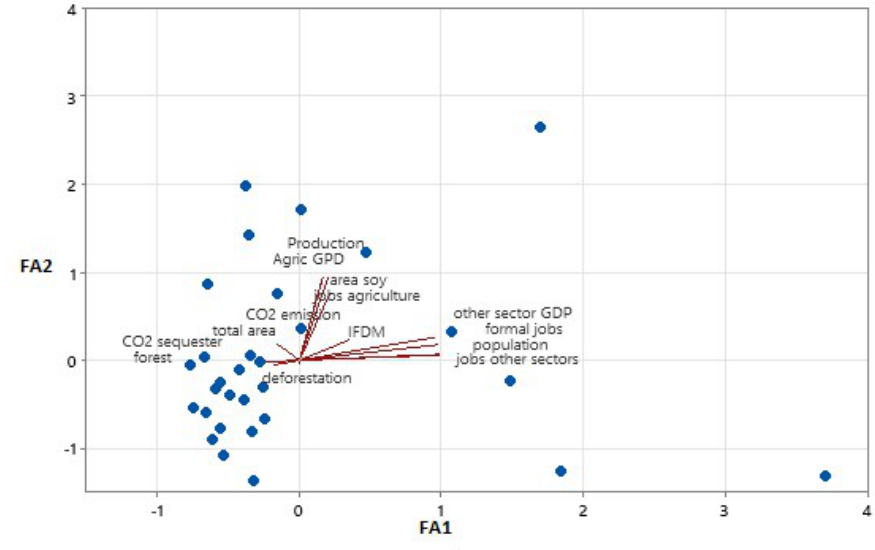
Figure 4. The factor analysis biplot, obtained by the overlapping of Figure 3a,b.